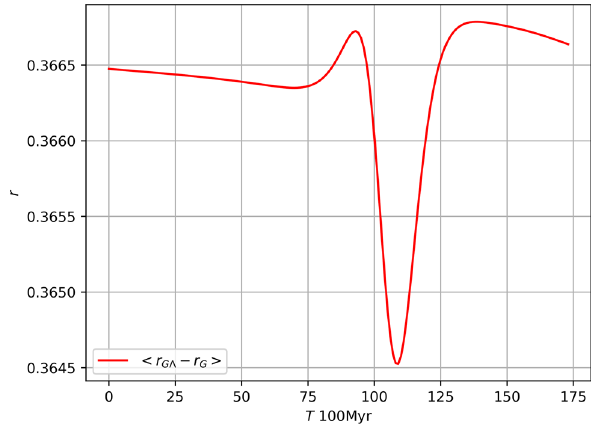
Fig. 2 The difference of the Ricci curvature values of curves in Fig. 1, i.e. at Newtonian and Λ -modified gravity laws